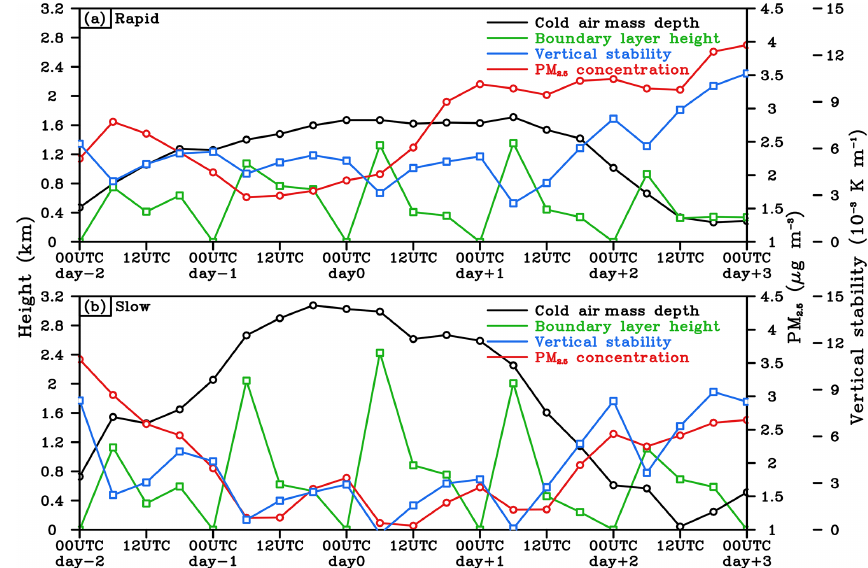
Figure 12. Evolution of the spatially averaged (NEC; 114–122 ◦ E, 30–40 ◦ N) cold air mass depth, atmospheric boundary layer height, verti- cal stability (1000–850hPa), and surface PM 2 . 5 concentration during (a) CAO_rapid event from 14 to 17 December 2016 and (b) CAO_slow event from 11 to 14 February 2018. Table 3. Averaged cold air mass properties and atmospheric boundary layer conditions on day 0 from control and sensitive experiments. Upward (downward) arrows denote that the value of sensitive experiment is greater (less) than the value in control experiment. Cold Atmospheric Negative Vertical Experiment air mass boundary layer heat content stability depth (hPa) height (m) ( − KhPa) (10 − 3 Km − 1 ) Control 165.6 597.2 1898.4 5.47 NHC_ C 163.9 579.9 1994.5 ↑ 6.79 ↑ NHC_ W 167.6 661.0 1745.9 ↓ 4.15 ↓ DP_ C 189.4 ↑ 727.4 ↑ 2447.9 DP_ W 118.8 ↓ 519.9 ↓